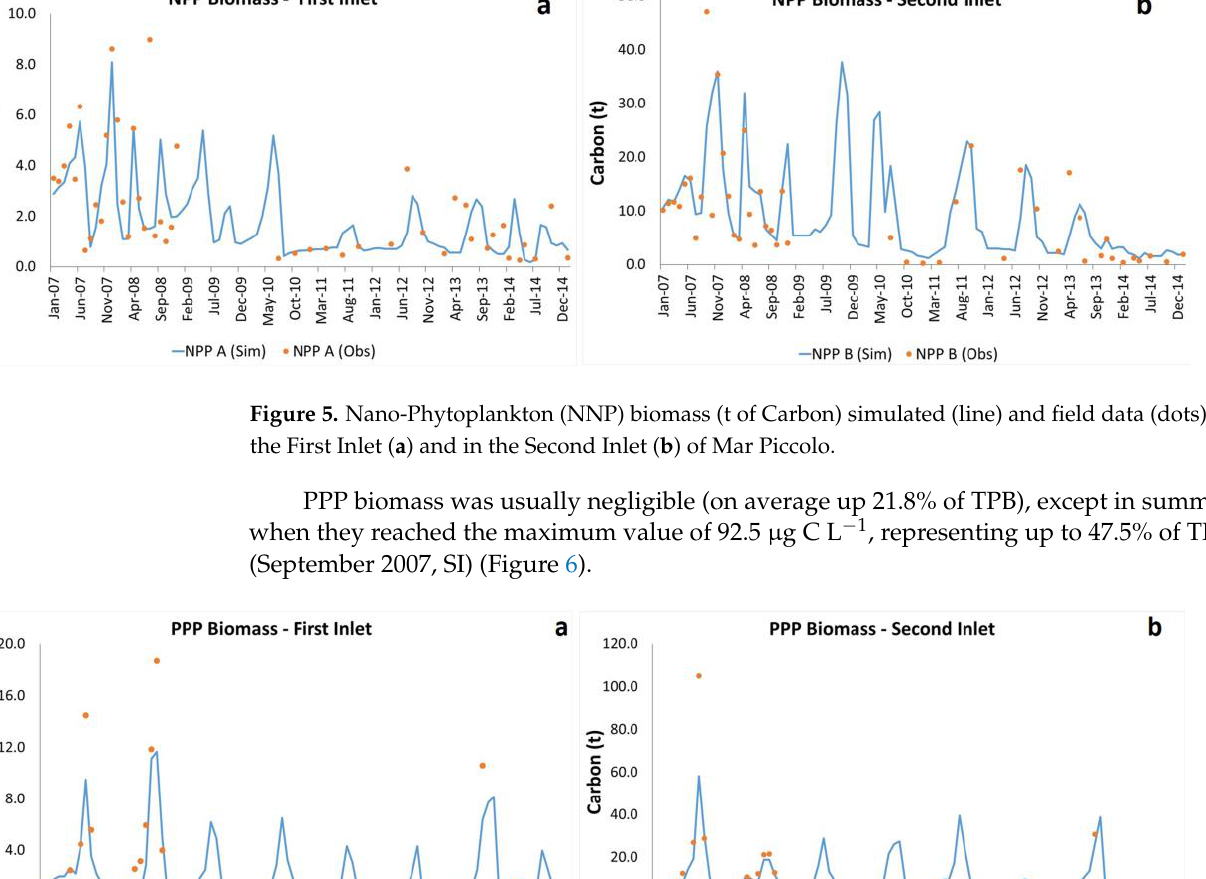
Figure 4. Micro-Phytoplankton (MPP) biomass (t of Carbon) simulated (line) and field data (dots) in the First Inlet ( a ) and in the Second Inlet ( b ) of Mar Piccolo.